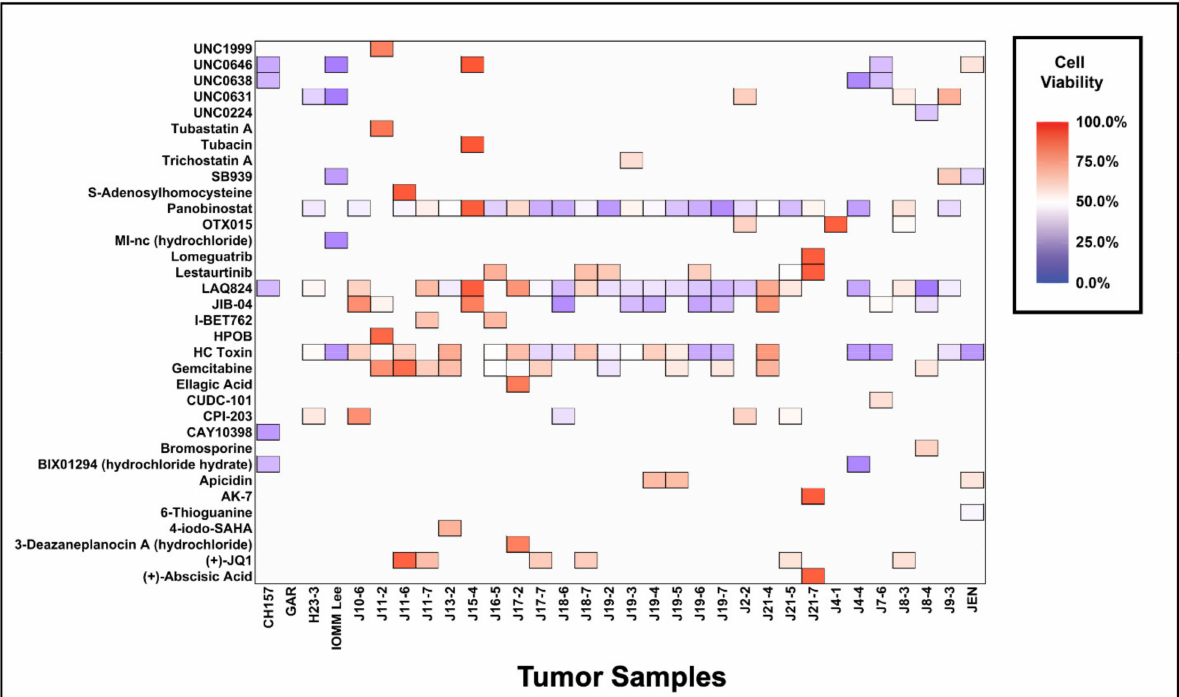
Figure 2. Top five most effective epigenetic compounds per tumor. Heat map of the most effective compounds, determined as the top five compounds that reduce cell viability the most for each tumor. The top five compounds are displayed as filled tiles in the heat map, while compounds that were not in the top five remain as white